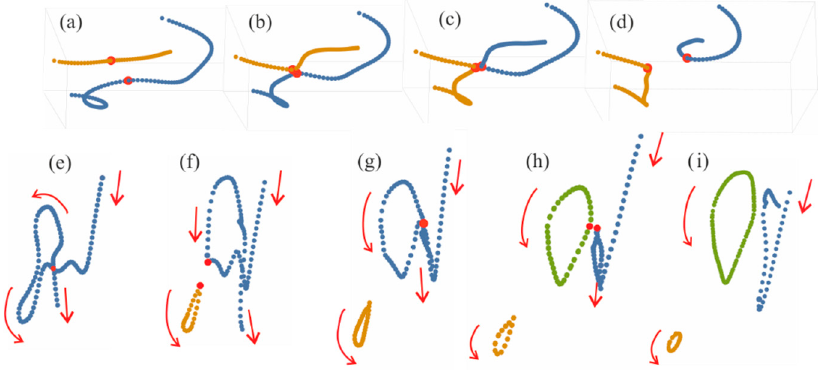
Figure 16. Two types of topological reactions with vortex lines: their reconnection ( a – d ) and separation of loops from the parent line ( e – i ). Evolution coordinate z increases from ( a ) to ( d ) and from ( e ) to ( i ).